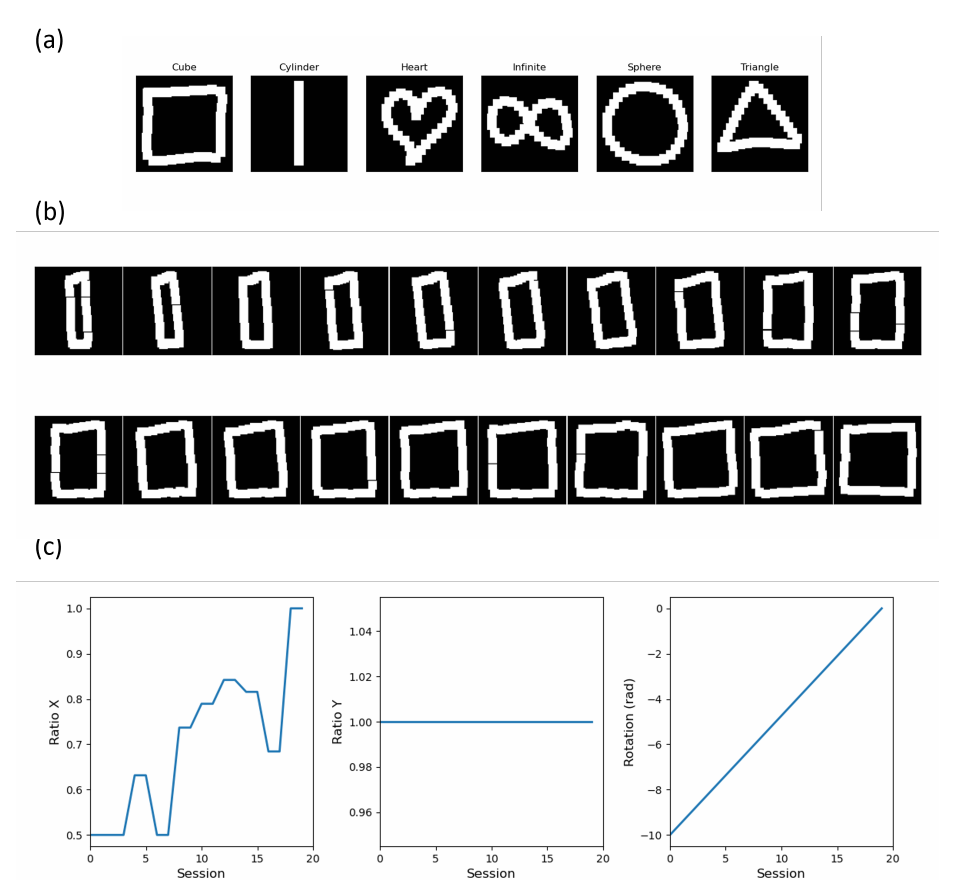
Figure 2. ( a ) Example of each movement recorded with the VR wireless controller. ( b ) Example of artificial data created for the movements “Cube”. A total of 20 movements are created based on the horizontal (Ratio X), vertical stretch (Ratio Y), and rotation factors ( c